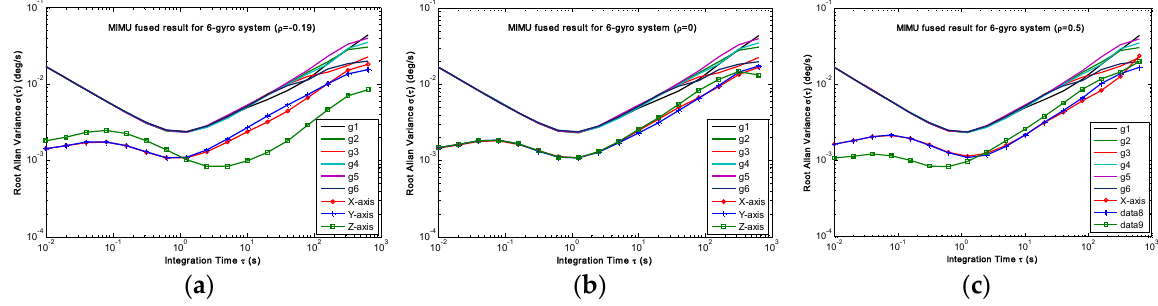
Figure 14. Plot of the compared Allan variance of 6-gyro MIMU for scheme 1: ( a ) ρ = − 0.19; ( b ) ρ = 0; ( c ) ρ = 0.5.